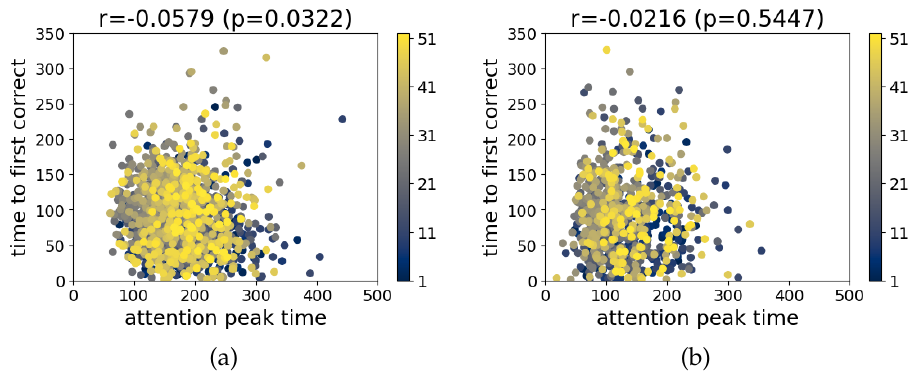
Figure 10. Correlation between attention layer peaks and time to first correct prediction for each of the models. ( a ) Att300 and ( b ) Att2500.